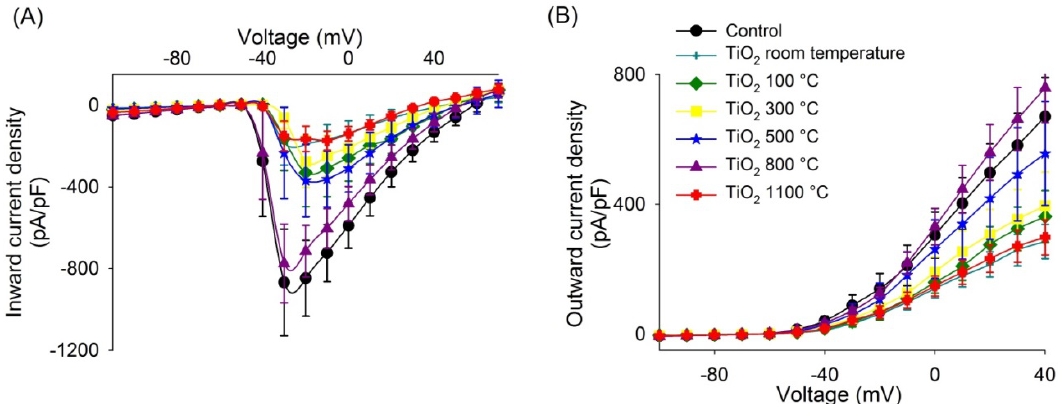
Figure 3. Inward and outward current density of the DRG neurons cultured in control substrate and TiO thin films. ( A ) Average inward current density as a function of voltage; 2 ( B ) Average outward current density as a function of voltage.